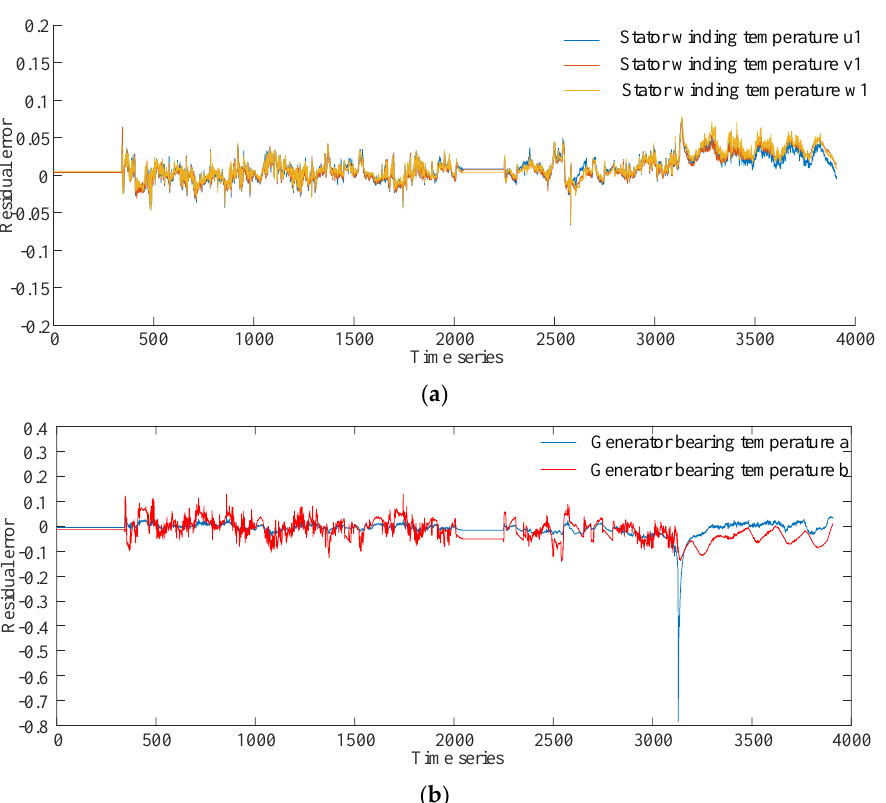
Figure 10. Test set reconstruction error. ( a ) Variation trend of temperature residual of generator stator windings. ( b ) Variation trend of temperature residual of generator bearing.